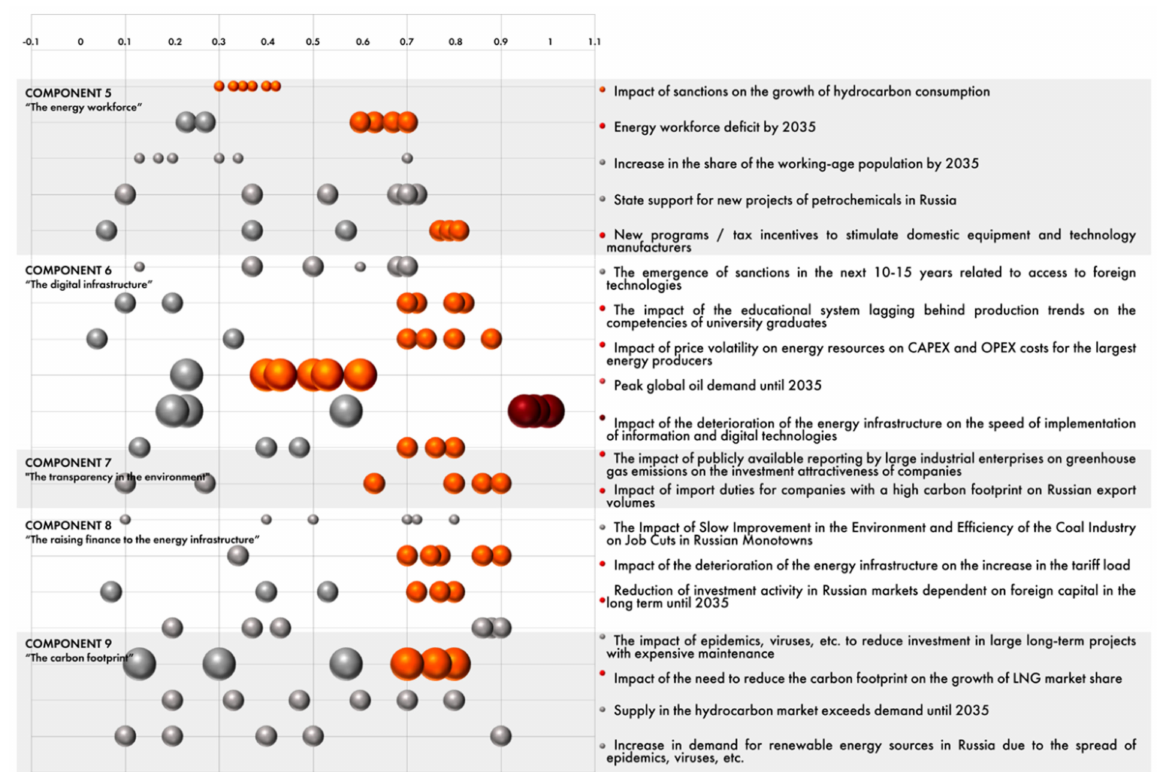
Figure 7. The generalized factorial model of scenario risks (components five to nine)